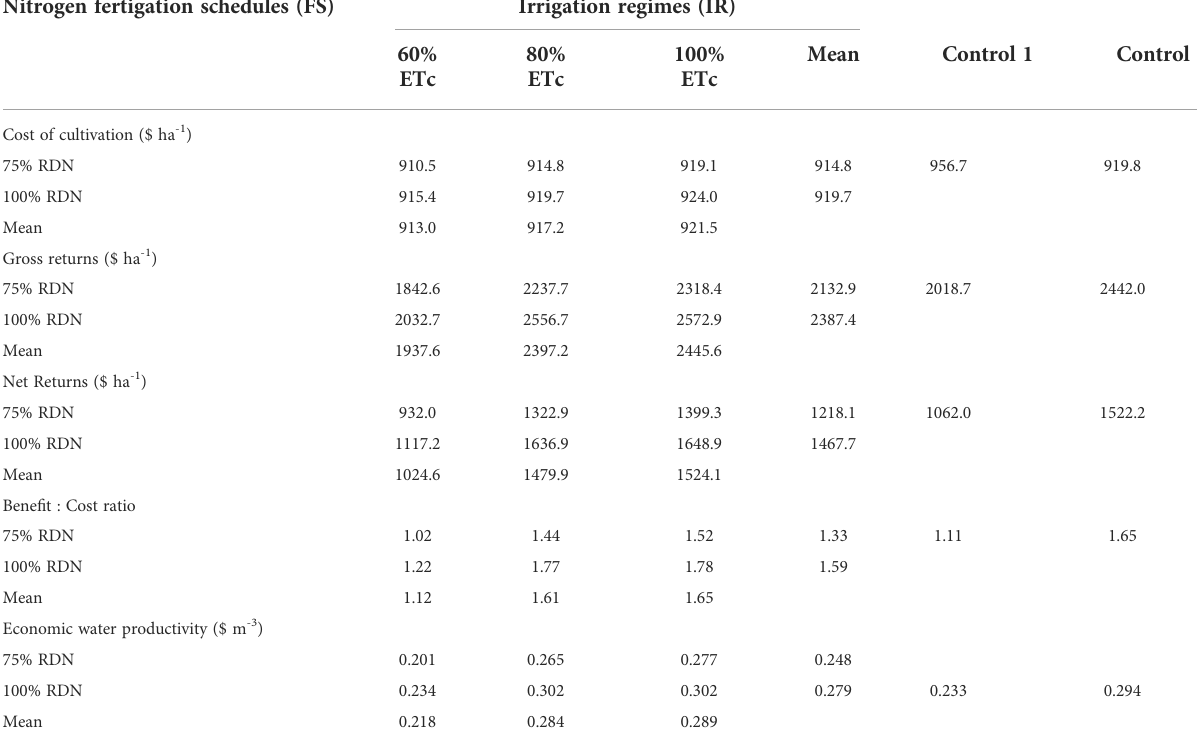
TABLE 10 Effect of various treatments on monetary parameters. Nitrogen fertigation schedules